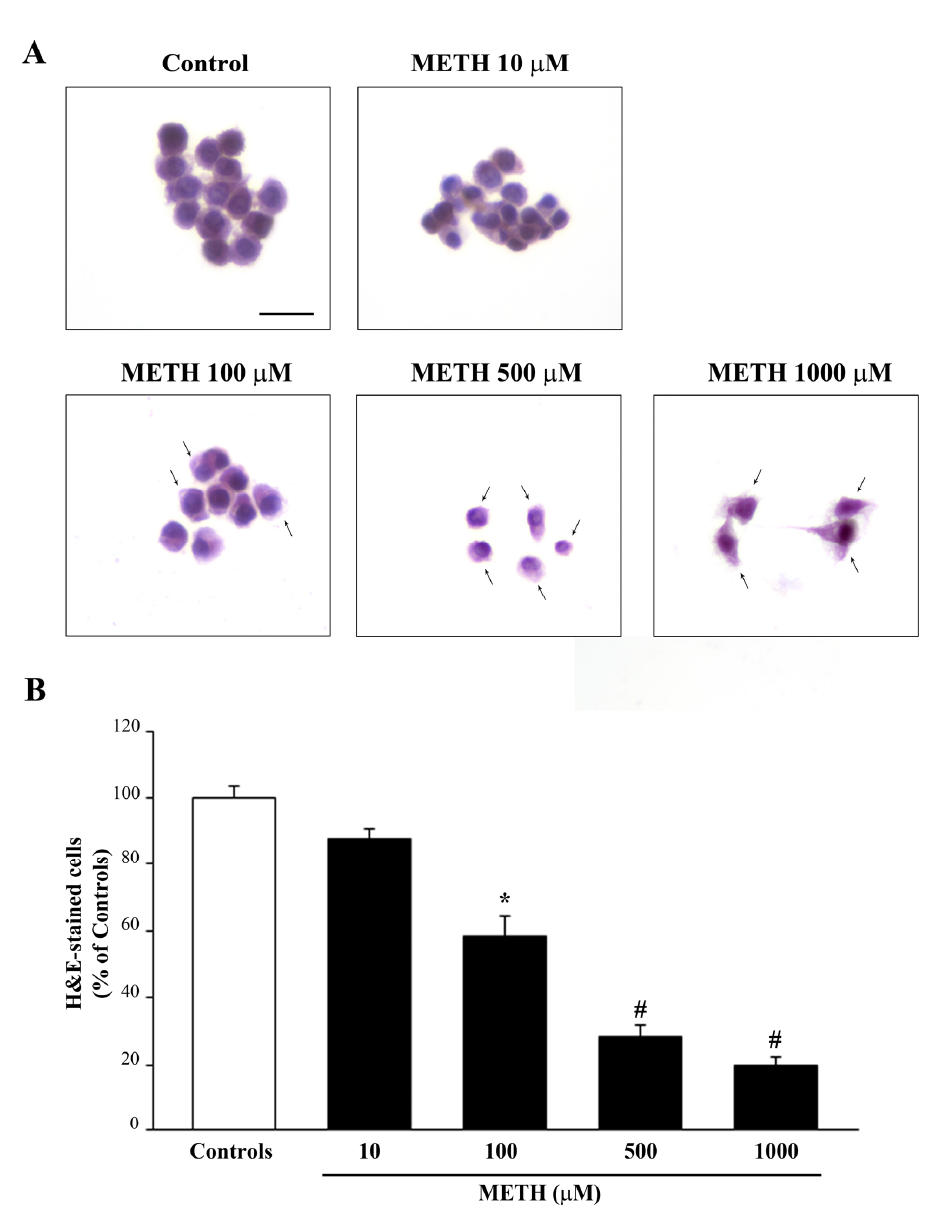
Figure 1. METH dose-dependently induces cell death. ( A ) Representative pictures of H&E-stained cells show that increasing doses of METH (from 10 µ M up to 1000 µ M) dose-dependently induces cell loss and morphological changes in spared cells (arrows). ( B ) The graph reports the percentage of cells counted after METH treatment (at doses ranging from 10 µ M up to 1000 µ M) compared with those counted in control conditions. Values are given as the mean percentage ± S.E.M. of cells counted from three independent experiments (assuming controls as 100%). * p ≤ 0.05 compared with controls; # p ≤ 0.05 compared with controls and METH 100 μ M. Scale bar = 14 μ m.